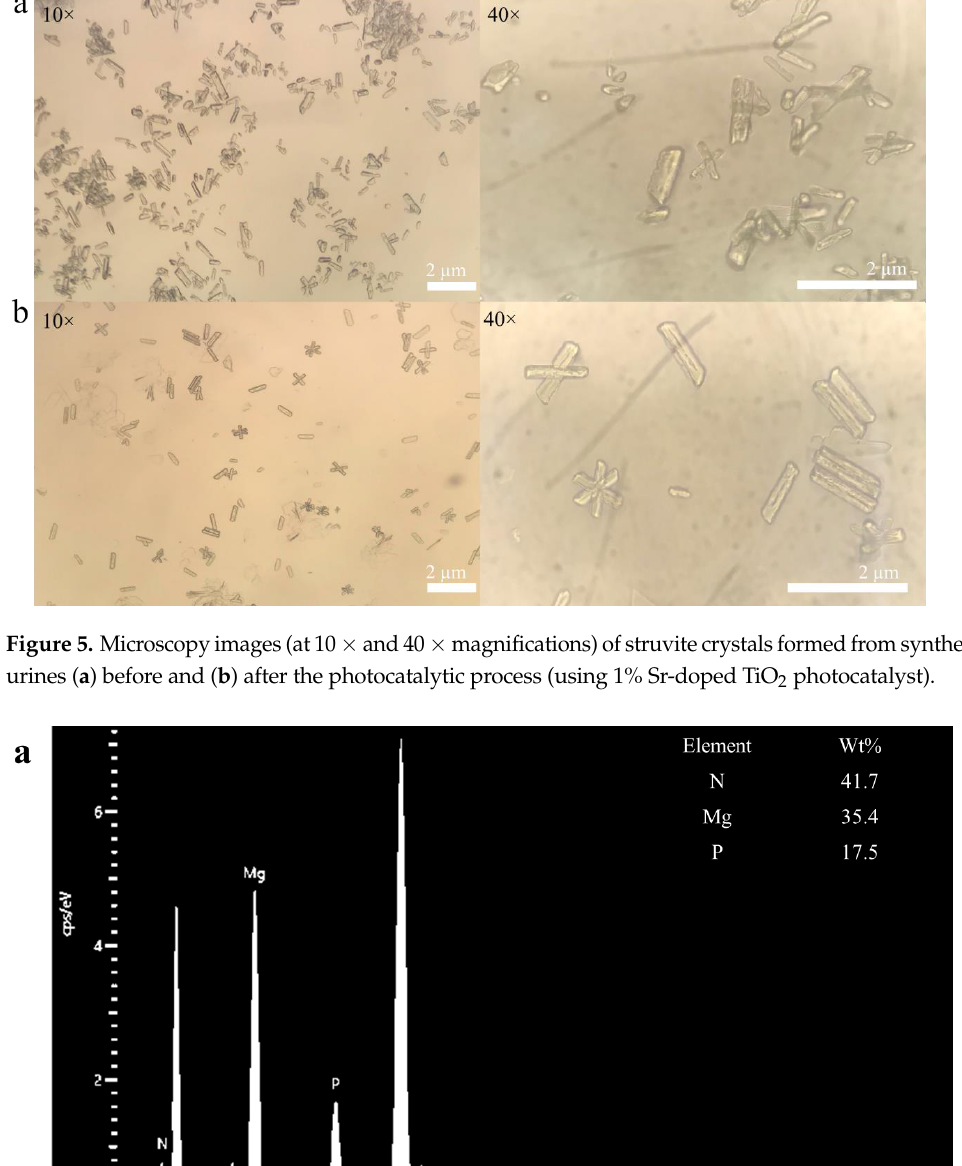
Figure 6. EDS spectra of struvite crystals formed from synthetic urines ( a ) before and ( b ) after the photocatalytic process (using 1% Sr-doped TiO 2 photocatalyst). 3. Materials and Methods 3.1. Materials Titanium (IV) dioxide (TiO 2) nanopowder (anatase phase, particle size <25 nm, 99.7% trace metals basis, Aldrich Chemistry (Darmstadt, Germany)) and strontium nitrate (ACS reagent, ≥99.0% (Sr (NO 3 ) 2) , Sigma-Aldrich (Darmstadt, Germany)) were purchased. Methanol from RCI Labscan (Bangkok, Thailand) was added as an electron donor. N 2 (99.995%) was used as the gas during the calcination of photocatalysts. Ar (99.995%) was used as the purge gas in the photocatalytic reactor. H 2 (99.99999%) was used as the stand- ard gas in gas chromatography (GC).